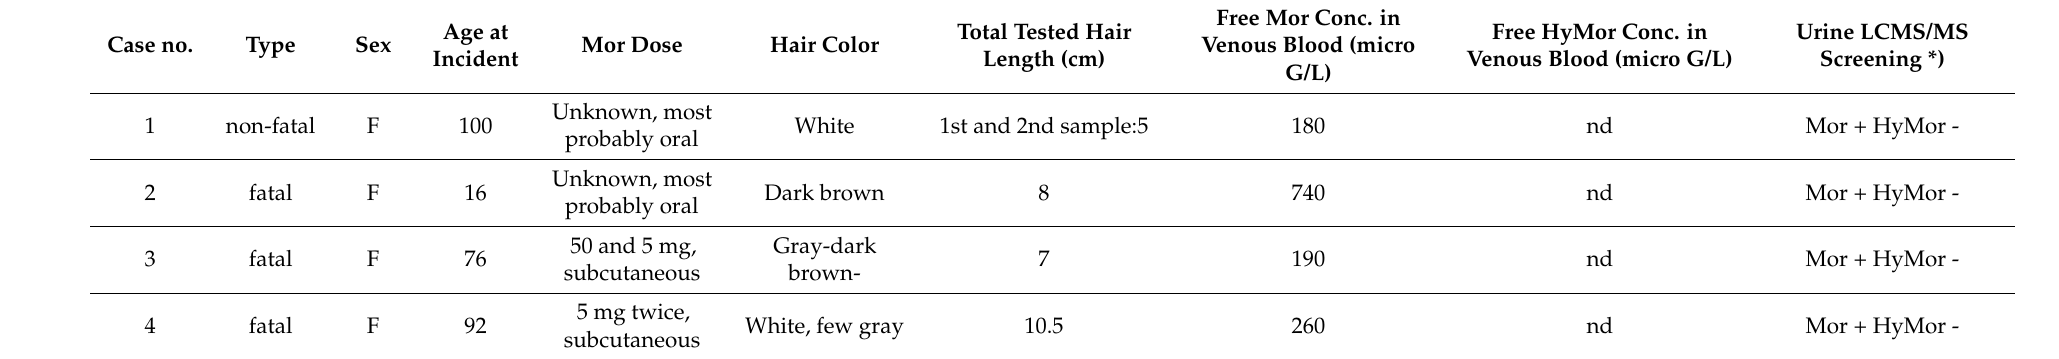
Table 1. Details on morphine intoxication